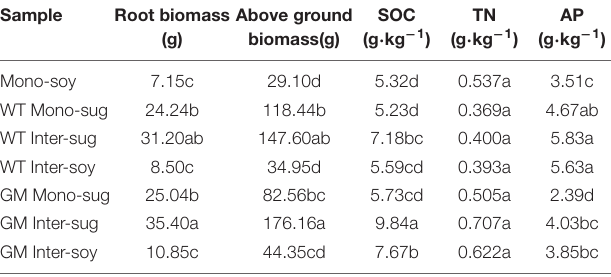
TABLE 1 | Soil characteristics of different